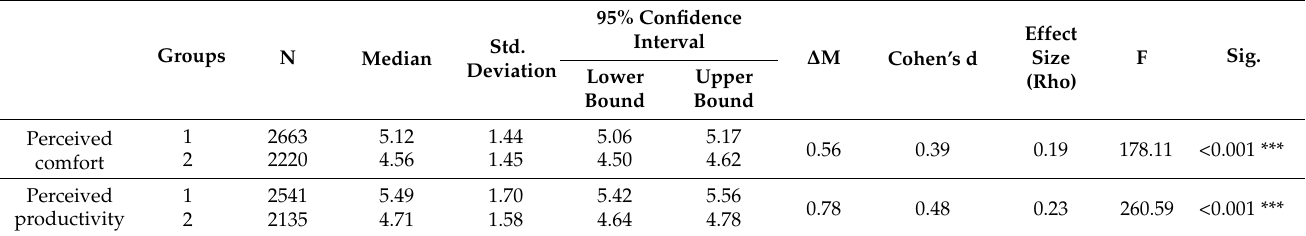
Group 1 means green buildings and Group 2 means non-certified buildings. N is the number of buildings. ∆ M is the difference between the median scores of Group 1 minus Group 2. F is the F-distribution. Sig. is the significance of the results of the p -value. *** p -value less than